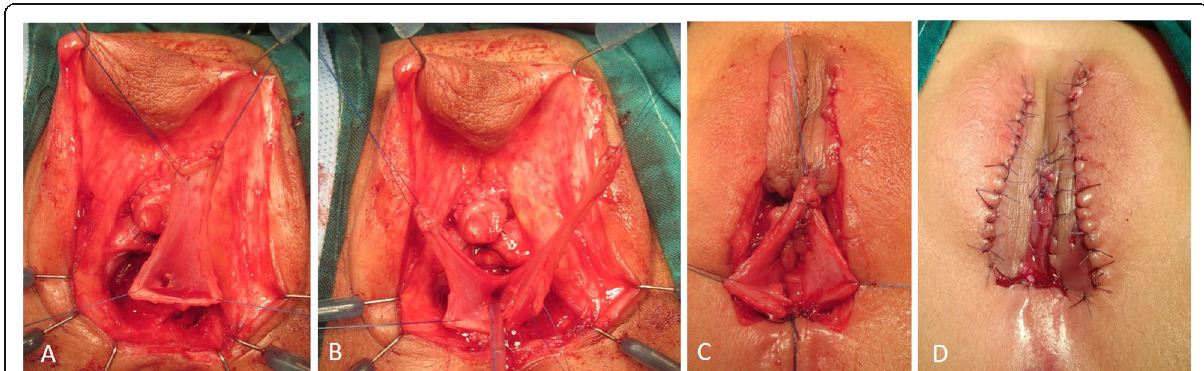
Fig. 8 Feminizing genitoplasty (cont.). A 60-month-old girl with CAH. Another midline incision is made dorsally through the dissected urogenital sinus splitting it into two equal flaps that will be rotated and sutured to the mucosal collar on both sides encircling the glans ( a – c ). Note: the distal urogenital sinus is used to provide mucosal lining for the new vestibule. d Reconstruction of the labia minora on both sides of